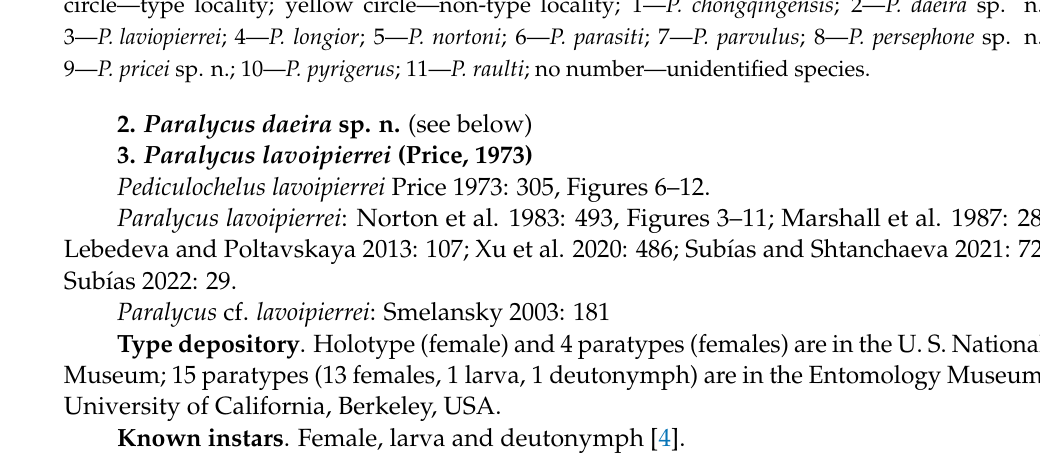
Figure 1. Geographic distribution of Paralycus ( A ) , habitats of Paralycus species ( B ). Symbols: red